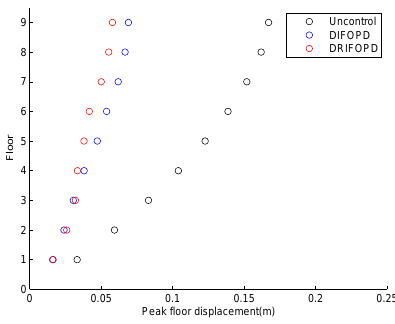
Figure 14. Maximum displacement of each floor under fault case 2.